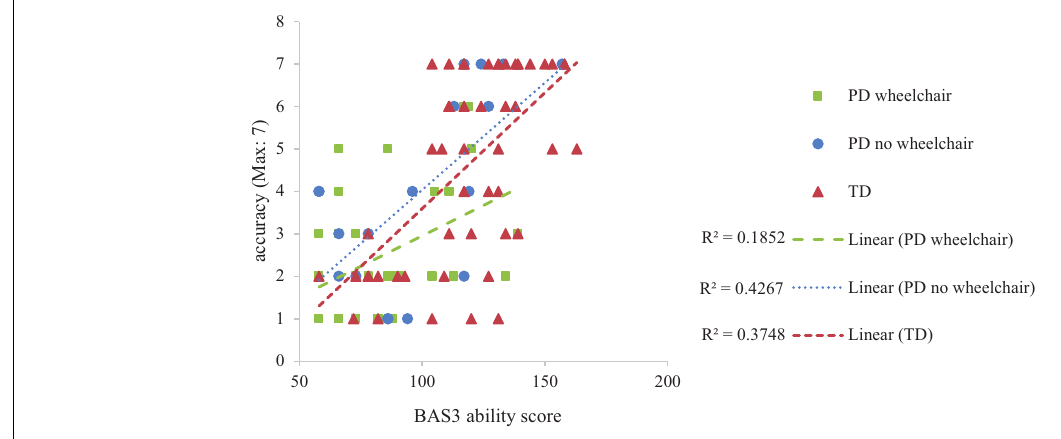
FIGURE 5 | Developmental trajectory of spatial programming accuracy.